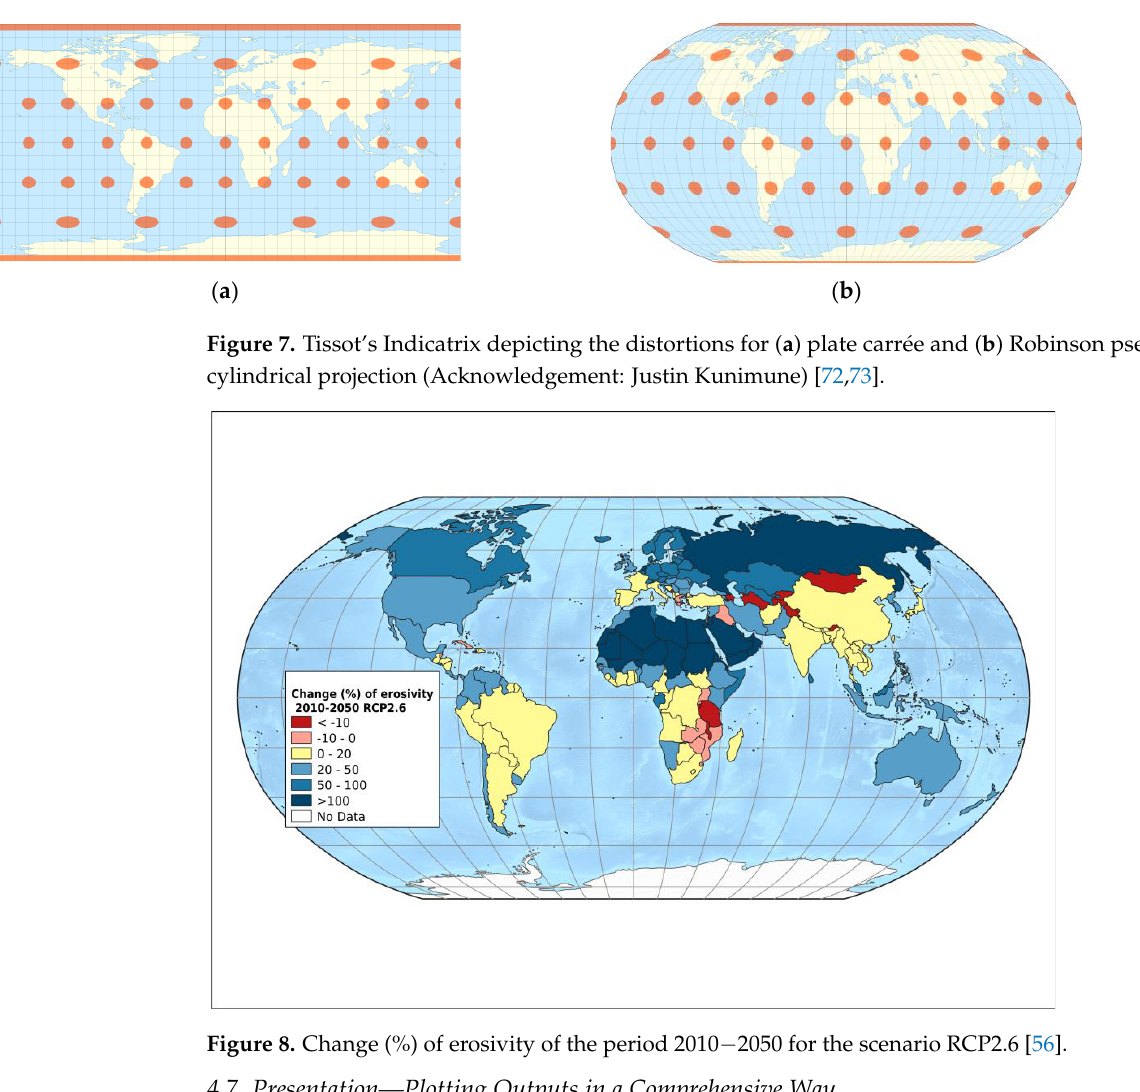
Figure 6. Hg stock (g ha − 1 ) in European topsoils [64].